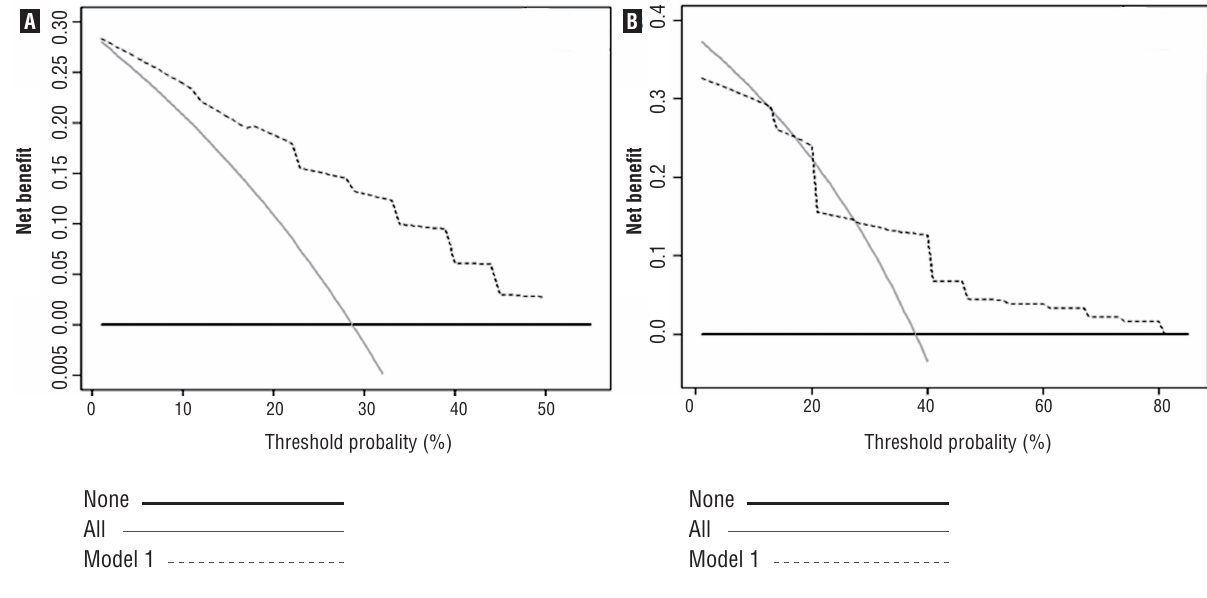
Figure 4 - Decision curve analysis for 5-year survival predictions. (A) Disease-specific survival. (B) Overall survival. In decision curve analysis, the y-axis measures net benefit, calculated by summing the benefits (true positives) and subtracting the harms (false positives). The straight line represents the assumption that all patients will die and the horizontal line represents the assumption that no patients will die. The dotted line indicates the net benefit of using the new